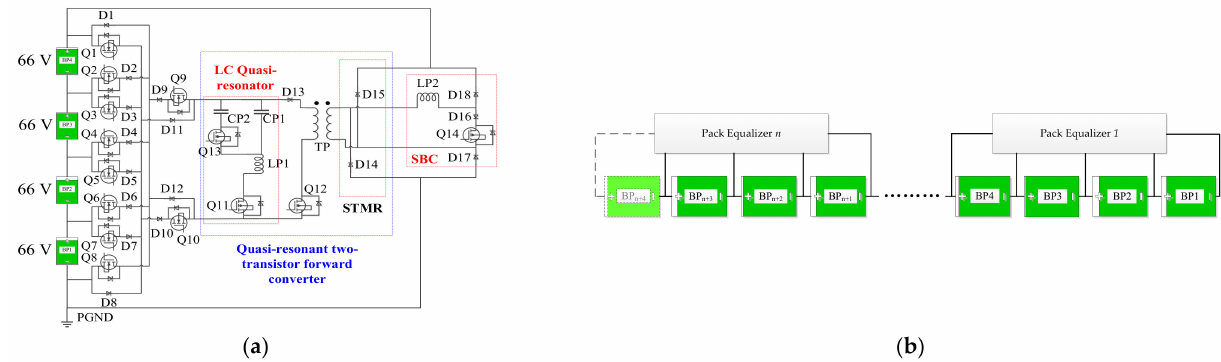
Figure 1. The proposed pack equalizer. ( a ) The circuit diagram of the proposed pack equalizer. ( b ) The application in a larger battery pack